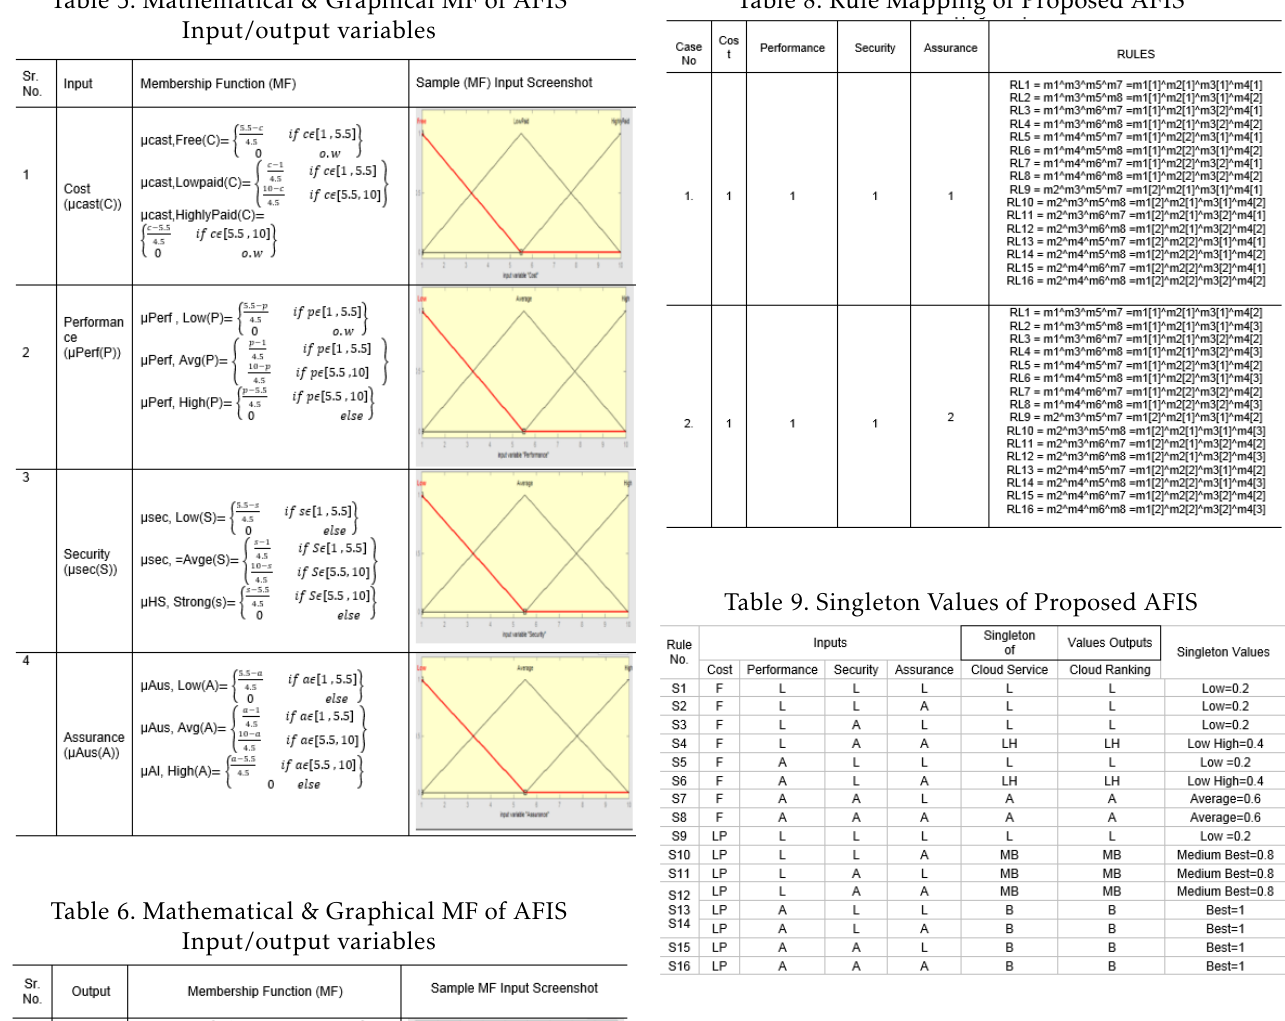
Table 5. Mathematical & Graphical MF of AFIS